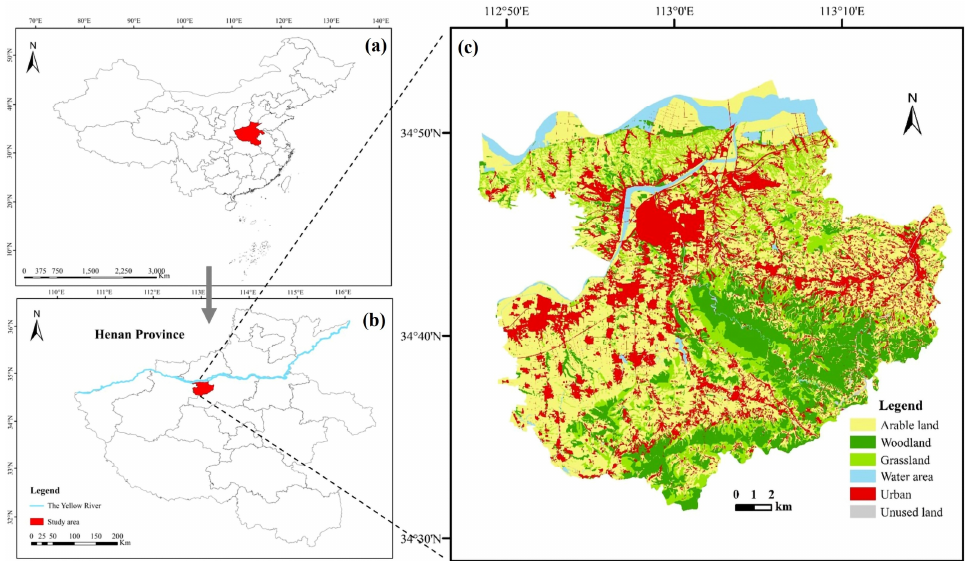
Figure 1. Geographical location of the study area. ( a ) Geographical location of Henan Province, China. ( b ) Geographical location of Gongyi City, Henan Province, China. ( c ) Land use types of Gongyi City.